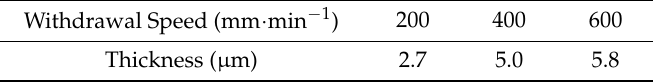
Figure 8. Scanning electron micrographs of cross-section for monolayer systems versus withdrawal speed: ( A ) 200, ( B ) 400 and ( C ) 600 mm · min − 1 . Table 2. Coating thickness for each withdrawal speed-monolayer systems.